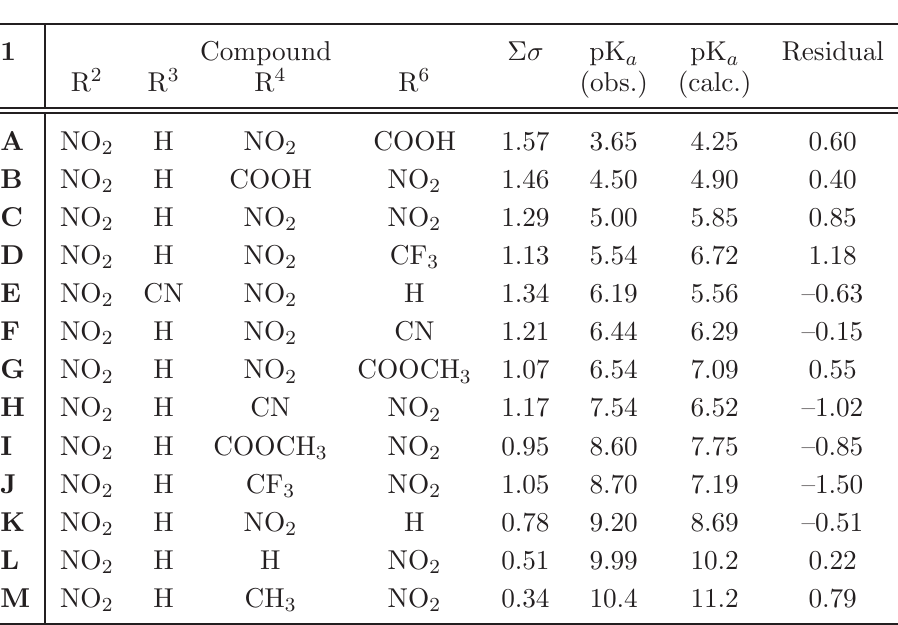
Table 2 Data for the acidity of 13 compounds 1A – 1M .